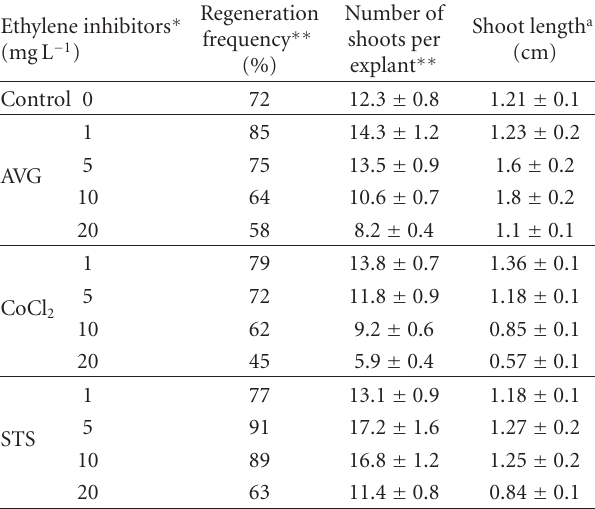
Table 1: E ff ect of di ff erent concentrations of ethylene inhibitors on on shoot regeneration and growth from leaf cultures of Sinningia speciosa after 6 weeks in culture on regeneration medium (MS medium with 2.0mg/L BA and 0.1mg/L